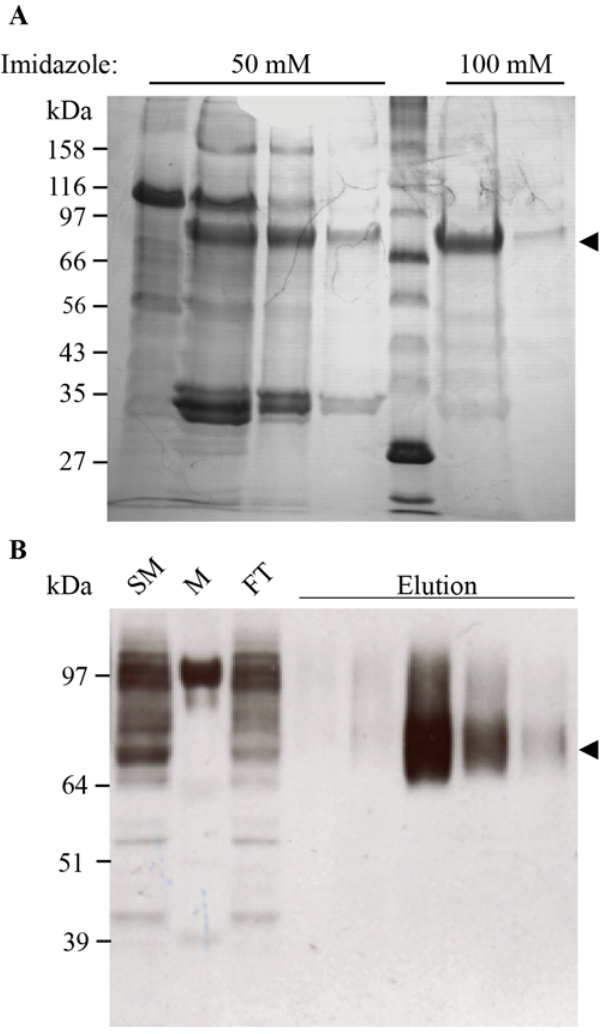
Fig 3. Electrophoretic analysis of GARP TS fractions from the final Ni-NTA chromatography. (A) Elution fractions of the Affigel Blue column were pooled and proteins bound on the Ni-NTA matrix overnight. Lane 1 – 4: Washing fractions, containing 50 mM imidazole; Lane 5: Protein Marker Broad Range (NEB; Ipswich, USA); Lane 6+7: Elution fractions containing 100 mM imidazole. The arrowhead marks the soluble form of GARP TS at a molecular weight of 75 kDa. Fractions were analyzed by 10% PAA SDS-PAGE und reducing conditions, followed by staining with coomassie brilliant blue. (B) The supernatant of TRP2 TS transfected Expi293F cells (Invitrogen; Darmstadt, Germany) were concentrated and applied to a Strep-Tactin matrix. SM: Starting Material; M: Protein Marker SeeBlue Plus 2 (Invitrogen; Darmstadt, Germany); FT: Flowthrough; Elution: Eluted fractions with 2.5 mM D-Desthiobiotin. The arrowhead marks the soluble TRP2 TS at a molecular weight of 75 kDa. Fractions were analyzed by 10% PAA SDS-PAGE und reducing conditions followed by western blotting on a PVDF membrane. For detection the blot was probed with anti-TRP2 antibody (Abcam; Cambridge, UK). As secondary antibody a peroxidase coupled anti-rabbit-IgG antibody (GE Healthcare; Solingen, Germany) was